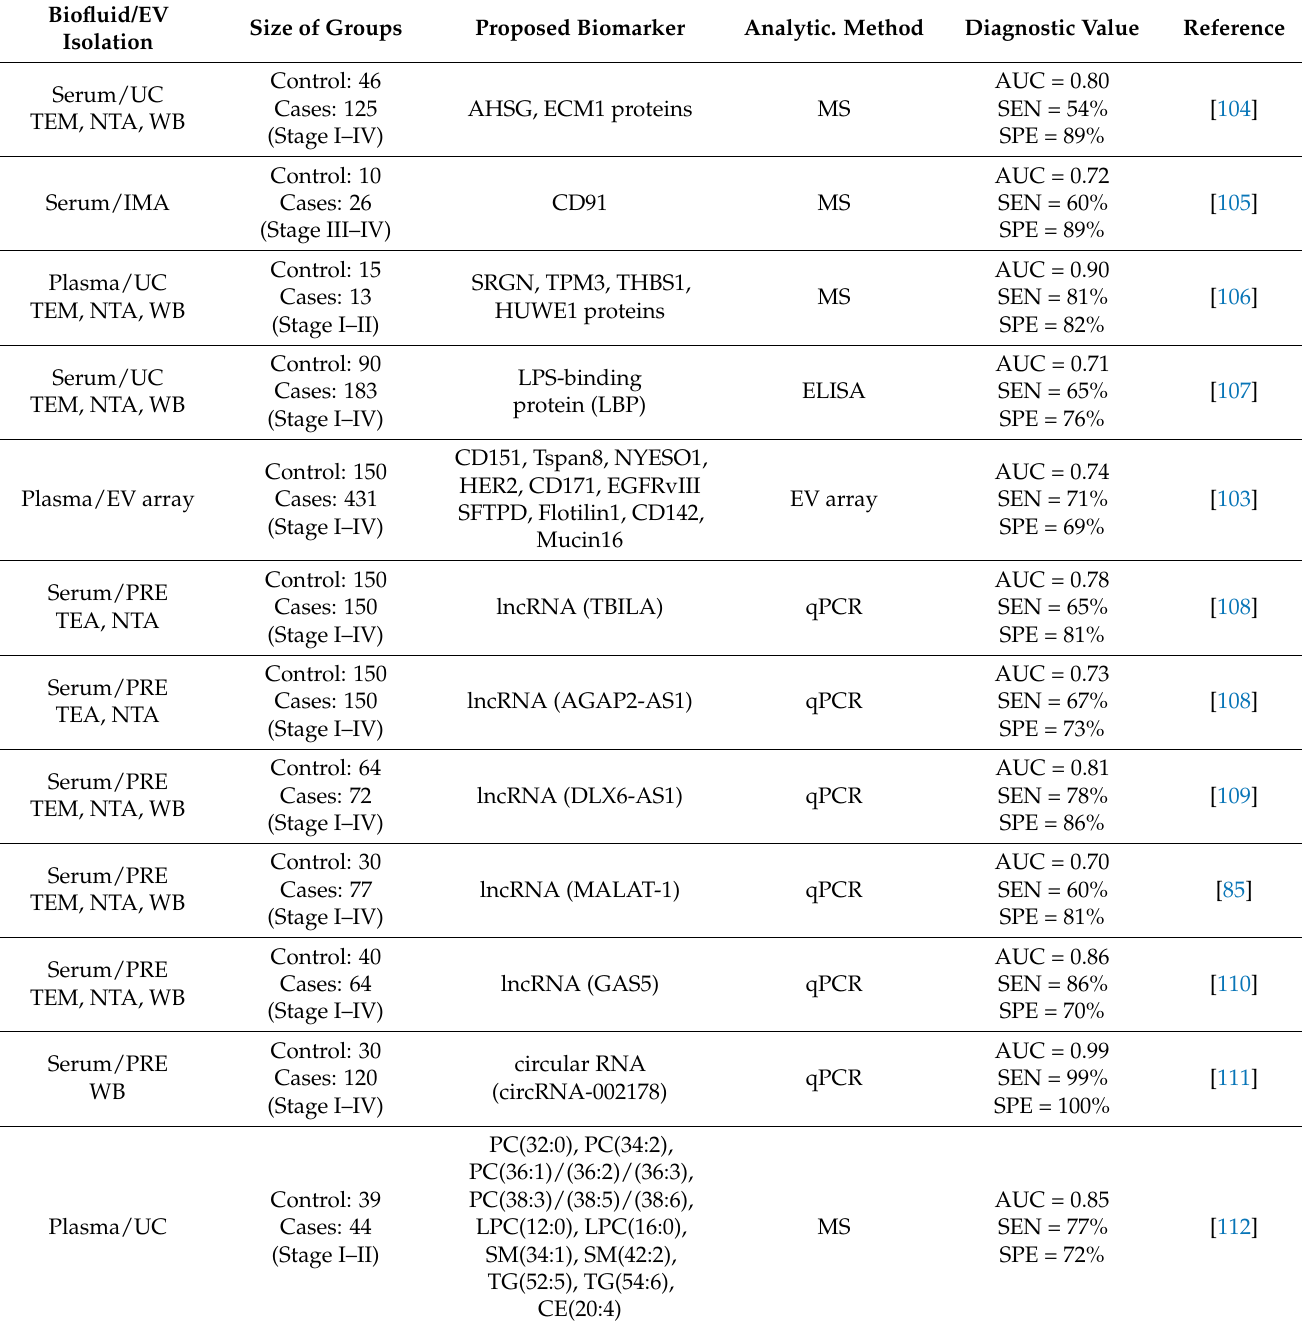
Table 2. Potential exosome biomarkers of lung